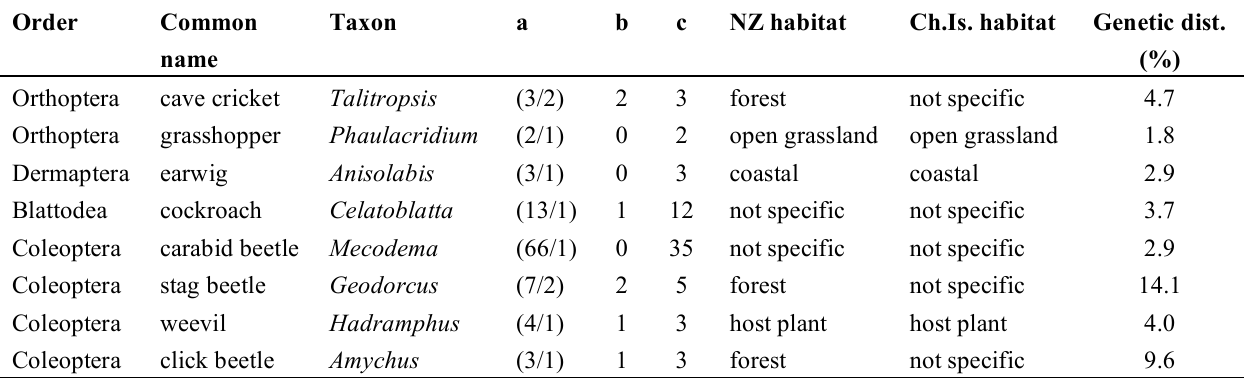
Table 1. Summary of taxa studied: a = number of known species in New Zealand/Chatham Is.; b = number of species endemic to Chatham Is.; c = number of species included in this study; NZ = New Zealand; Ch.Is. = Chatham Islands; Genetic dist. = maximum uncorrected genetic distances between sister taxa in NZ and